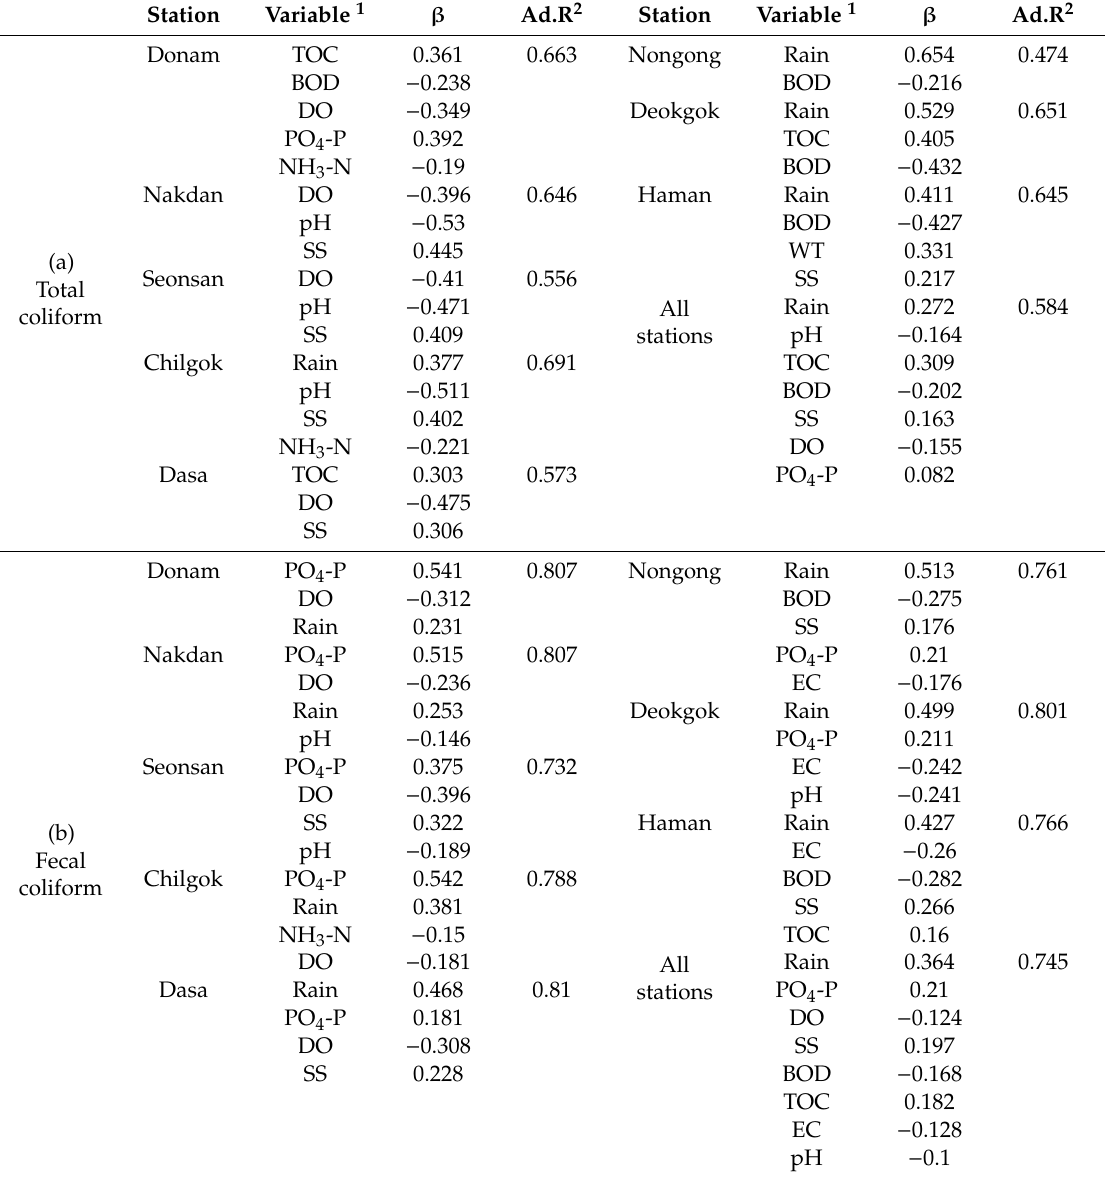
Table 3. Multiple regression results between total (a) and fecal (b) coliforms and water quality factors at each weir station. Tables A1 and A2 in Appendix A have details for multiple regression